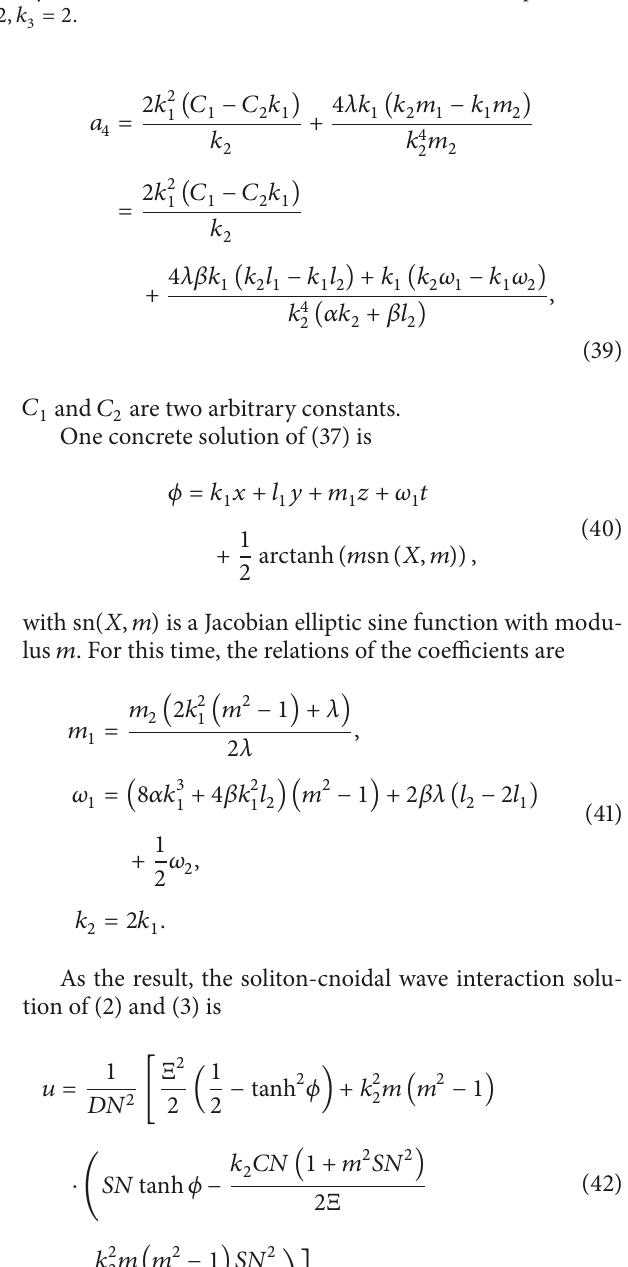
,𝑐 ,𝑐 ,𝑘 1 2 3 1 are all taken